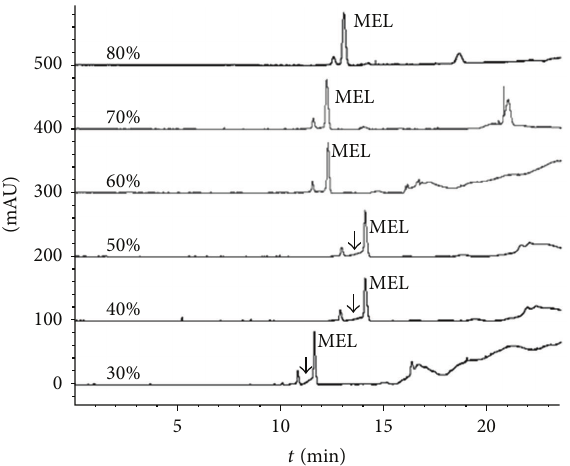
Figure 3: Electropherograms of milk treated with different percent- ages of acetonitrile. Condition: samples were treated with different percentages of acetonitrile (v/v) and were injected hydrodynami- cally at 50 mBar for 50 s. All samples contain 10mmol/L NaCl and 8 mmol/LpH 2.8 phosphate solution and 3 𝜇 mol/L